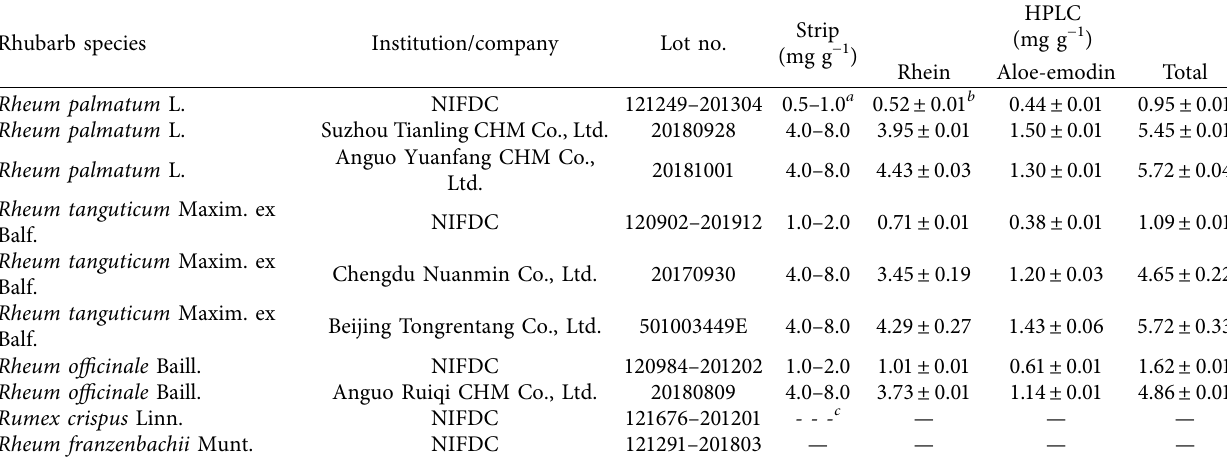
Table 1: Determination of rhein and aloe-emodin contents in rhubarb samples by CGIC strip and HPLC. Rhubarb species